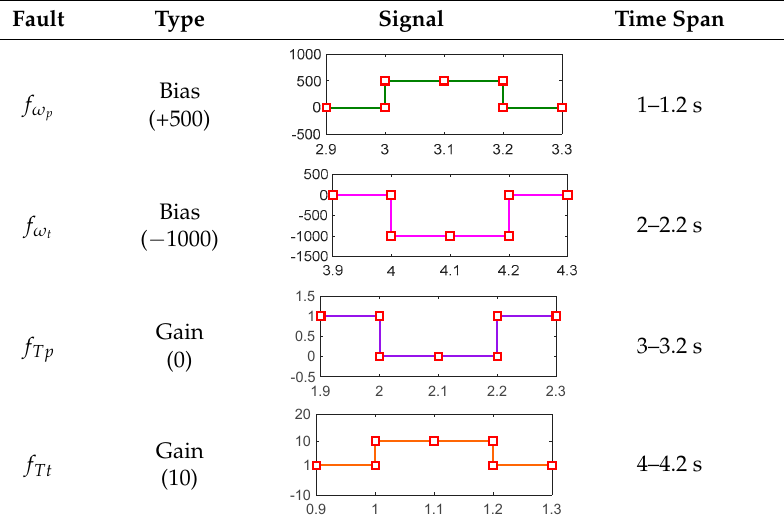
Figure 14. Measurement of four sensors in Pohl’s experiment: ( a ) input torque ( 𝑇 (cid:3043) ) and output torque ( 𝑇 (cid:3047) ); ( b ) input speed ( 𝜔 (cid:3043) ) and output speed ( 𝜔 (cid:3047) ).